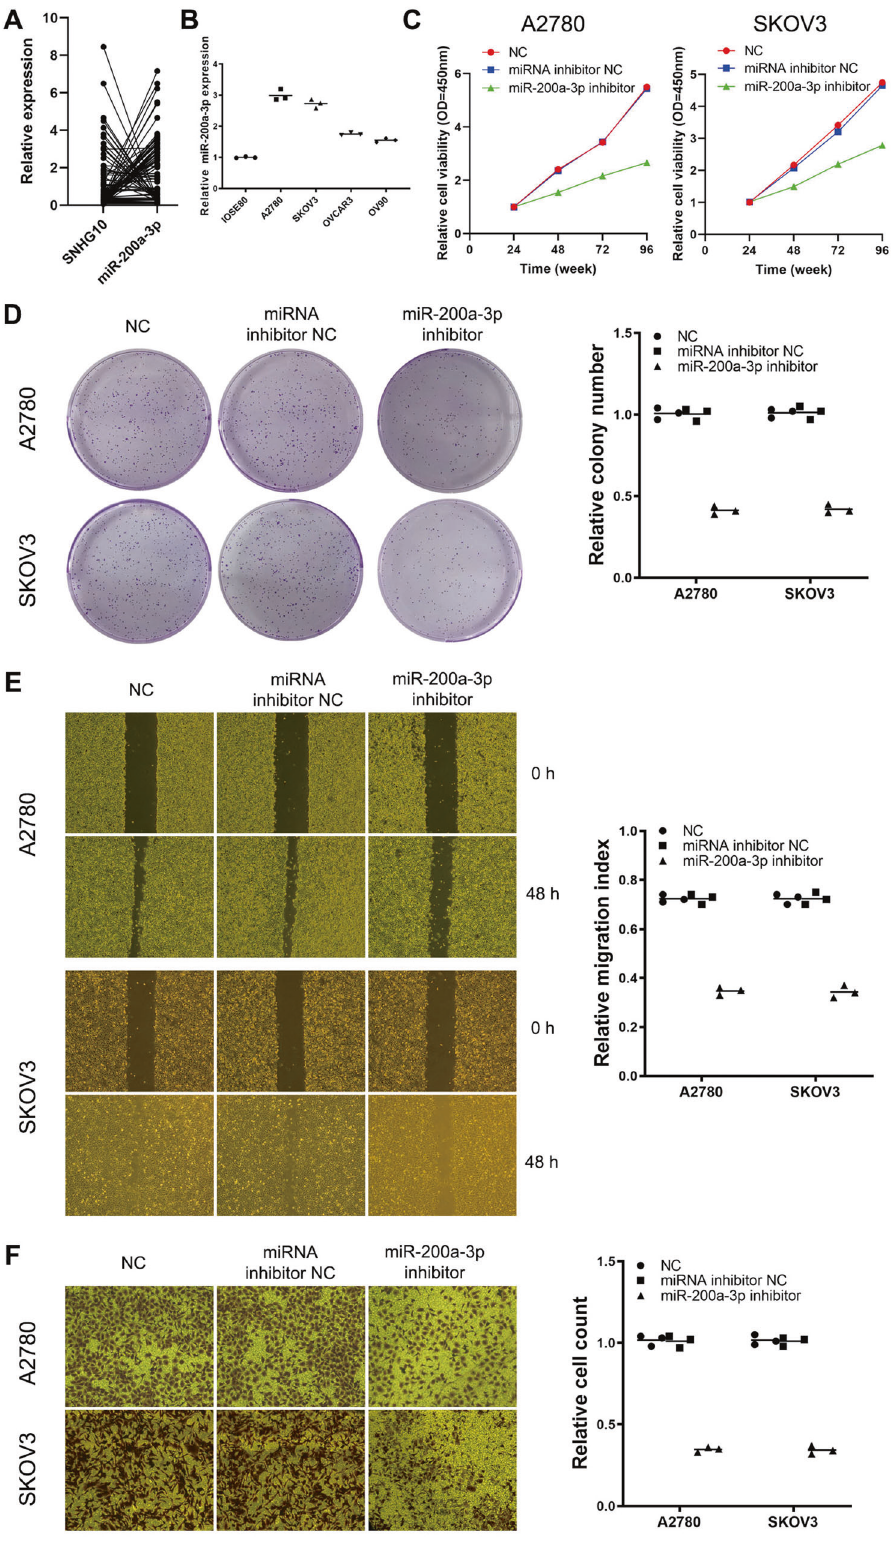
Fig. 4 miR-200a-3p inhibitor suppresses the proliferation, migration, and invasion of EOC cells in vitro. A Correlation between SNHG10 and miR-200a-3p in EOC tissues ( N = 85). B The expression of miR-200a-3p in EOC cell lines, normal ovarian epithelial cell IOSE80 as control. C miR-200a-3p inhibitor suppressed the proliferation ability in EOC cells, assayed by CCK-8 method. Plots indicate mean. D miR-200a-3p inhibitor suppressed the colony formation ability in EOC cells. E miR-200a-3p inhibitor suppressed the migration ability in EOC cells, assayed by wound-healing experiment. F miR-200a-3p inhibitor suppressed the invasion ability in EOC cells, assayed by transwell. The experiments were conducted in triplicate.